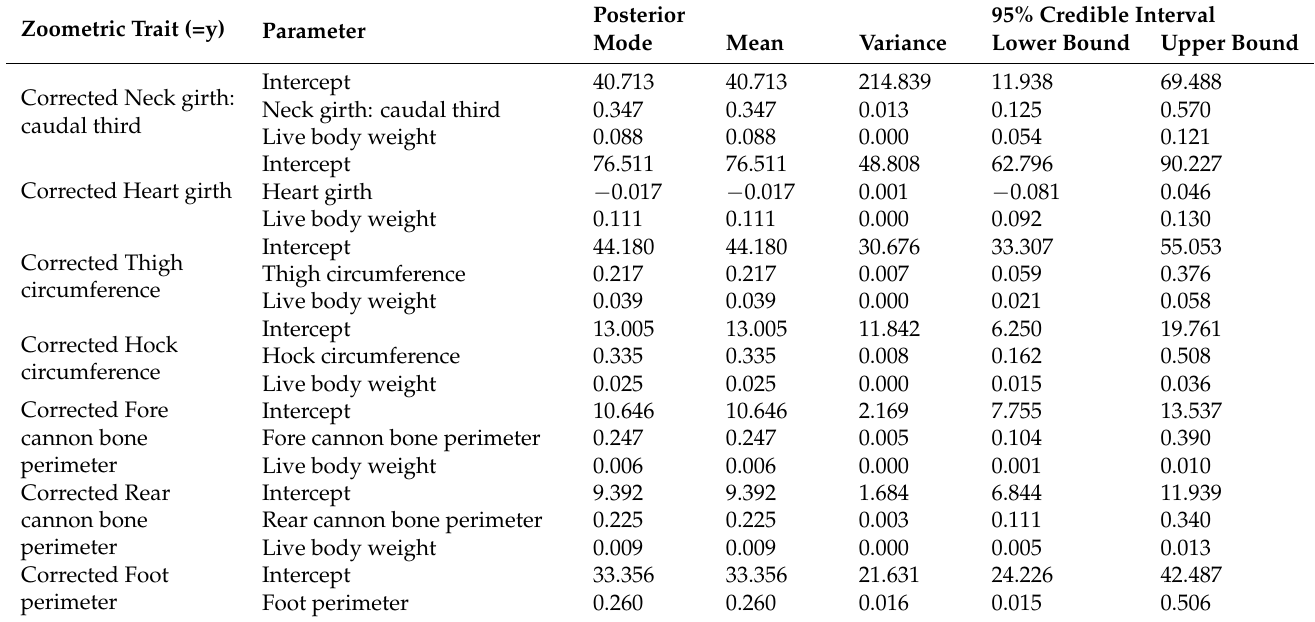
Table 3. Bayesian estimates of posterior distribution statistics for unstandardized linear regression coefficients for digital measurements and live body weight as regressors for the zoometric traits for which Average/Cronbach’s alpha did not surpass 0.600 at direct translation in the first round.